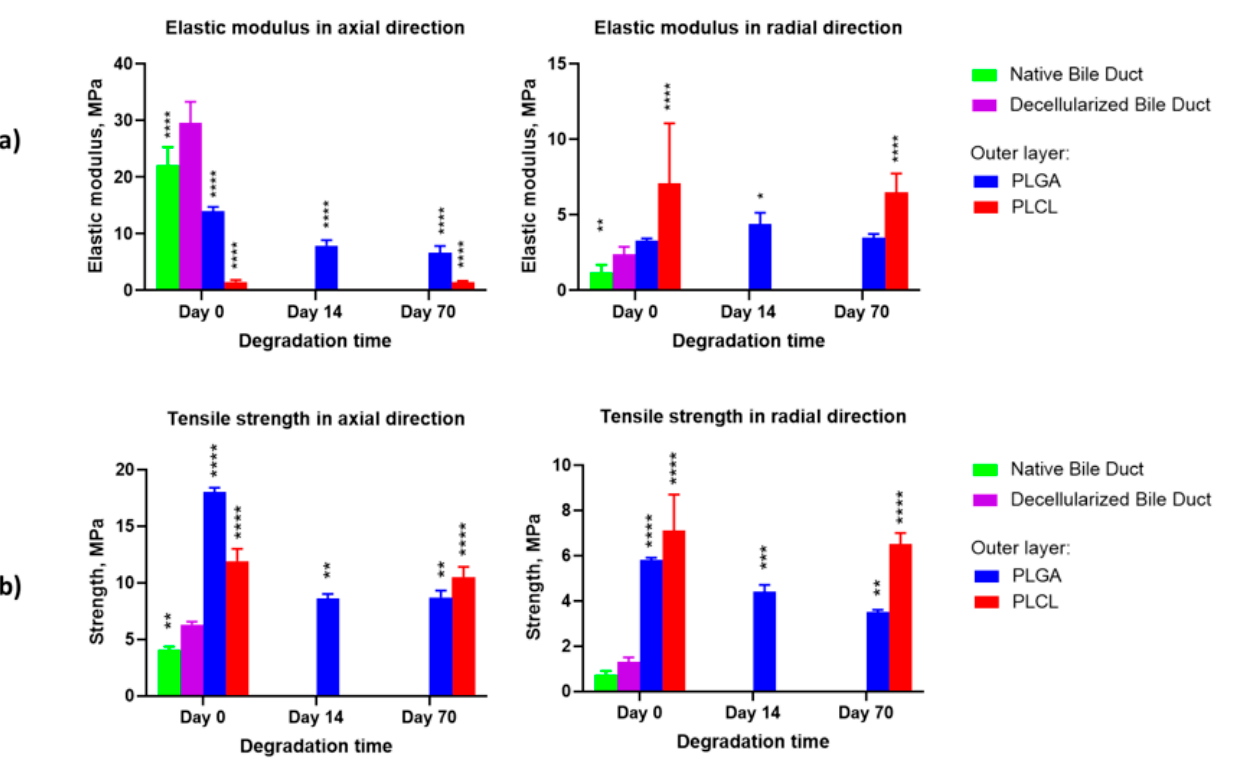
Figure 7. The results of the mechanical properties investigation in the tubular scaffolds with an outer layer derived from PLGA or PLCL, after degradation in bile: ( a ) Elastic modulus in the axial and radial directions; ( b ) Tensile strength in the axial and radial directions. Statistical significance is shown in comparison to the decellularized bile duct properties: *— p < 0.05; **— p < 0.01; ***— p < 0.001; ****— p <